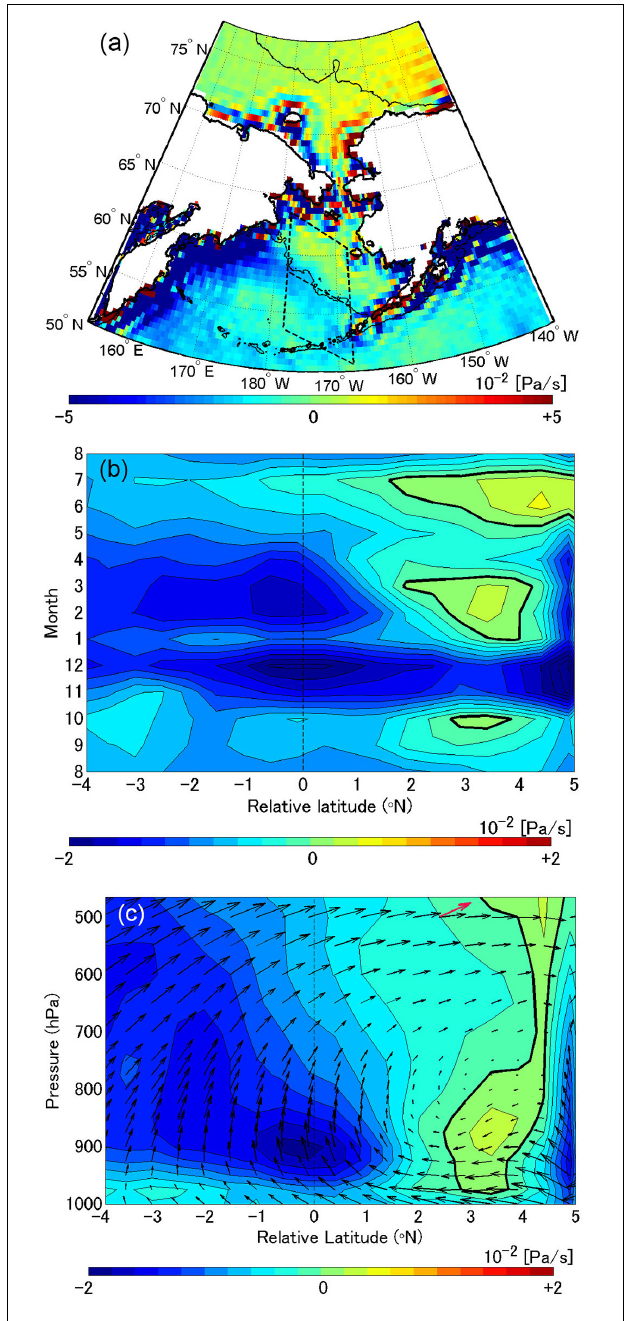
FIGURE 6 | (a) Annual-mean climatology and (b) latitude-time section of vertical velocity between 850 and 900 hPa. (c) Latitude-altitude section of vertical velocity (color) and two-dimensional wind vector for February to March. Scaling for the arrows is given near the upper-right corner in (c) (red arrow, meridional and vertical components of 3.0 m s − 1 and 1.0 × 10 − 2 Pa s − 1 ). Black bold lines in (b, c) are zero contours. The black dashed box in (a) is the average domain for (b,c)